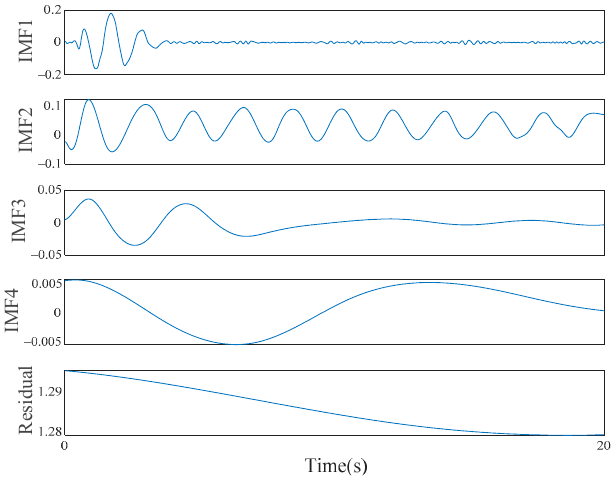
Figure 16. Effective IMFs and a residual of real-time signals.